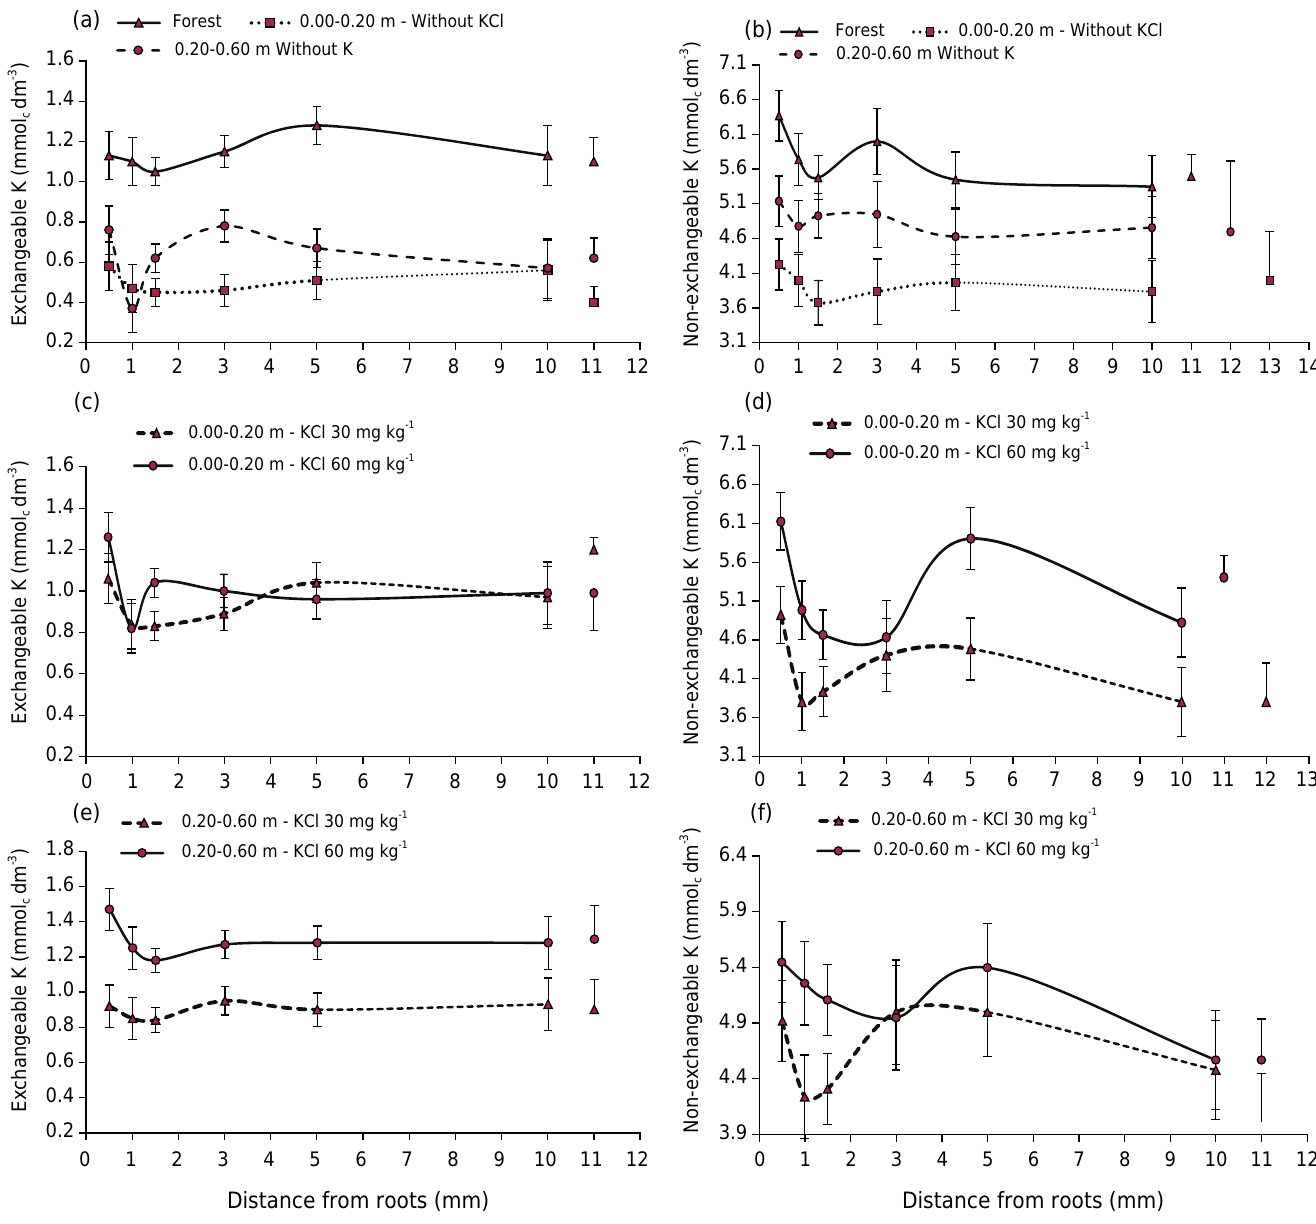
Figure 3. Exchangeable K (a, c, and e) and non-exchangeable K (b, d, and f) in cultivated soils as affected by K fertilization. Vertical bars in black show the LSD (p<0.05), and compare distances within each treatment, and vertical bars in gray show the LSD (p<0.05) and compare between each distance.